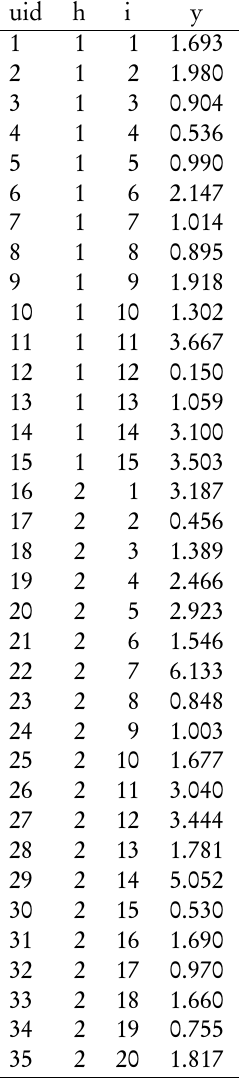
A toy population from which two overlapping frames are